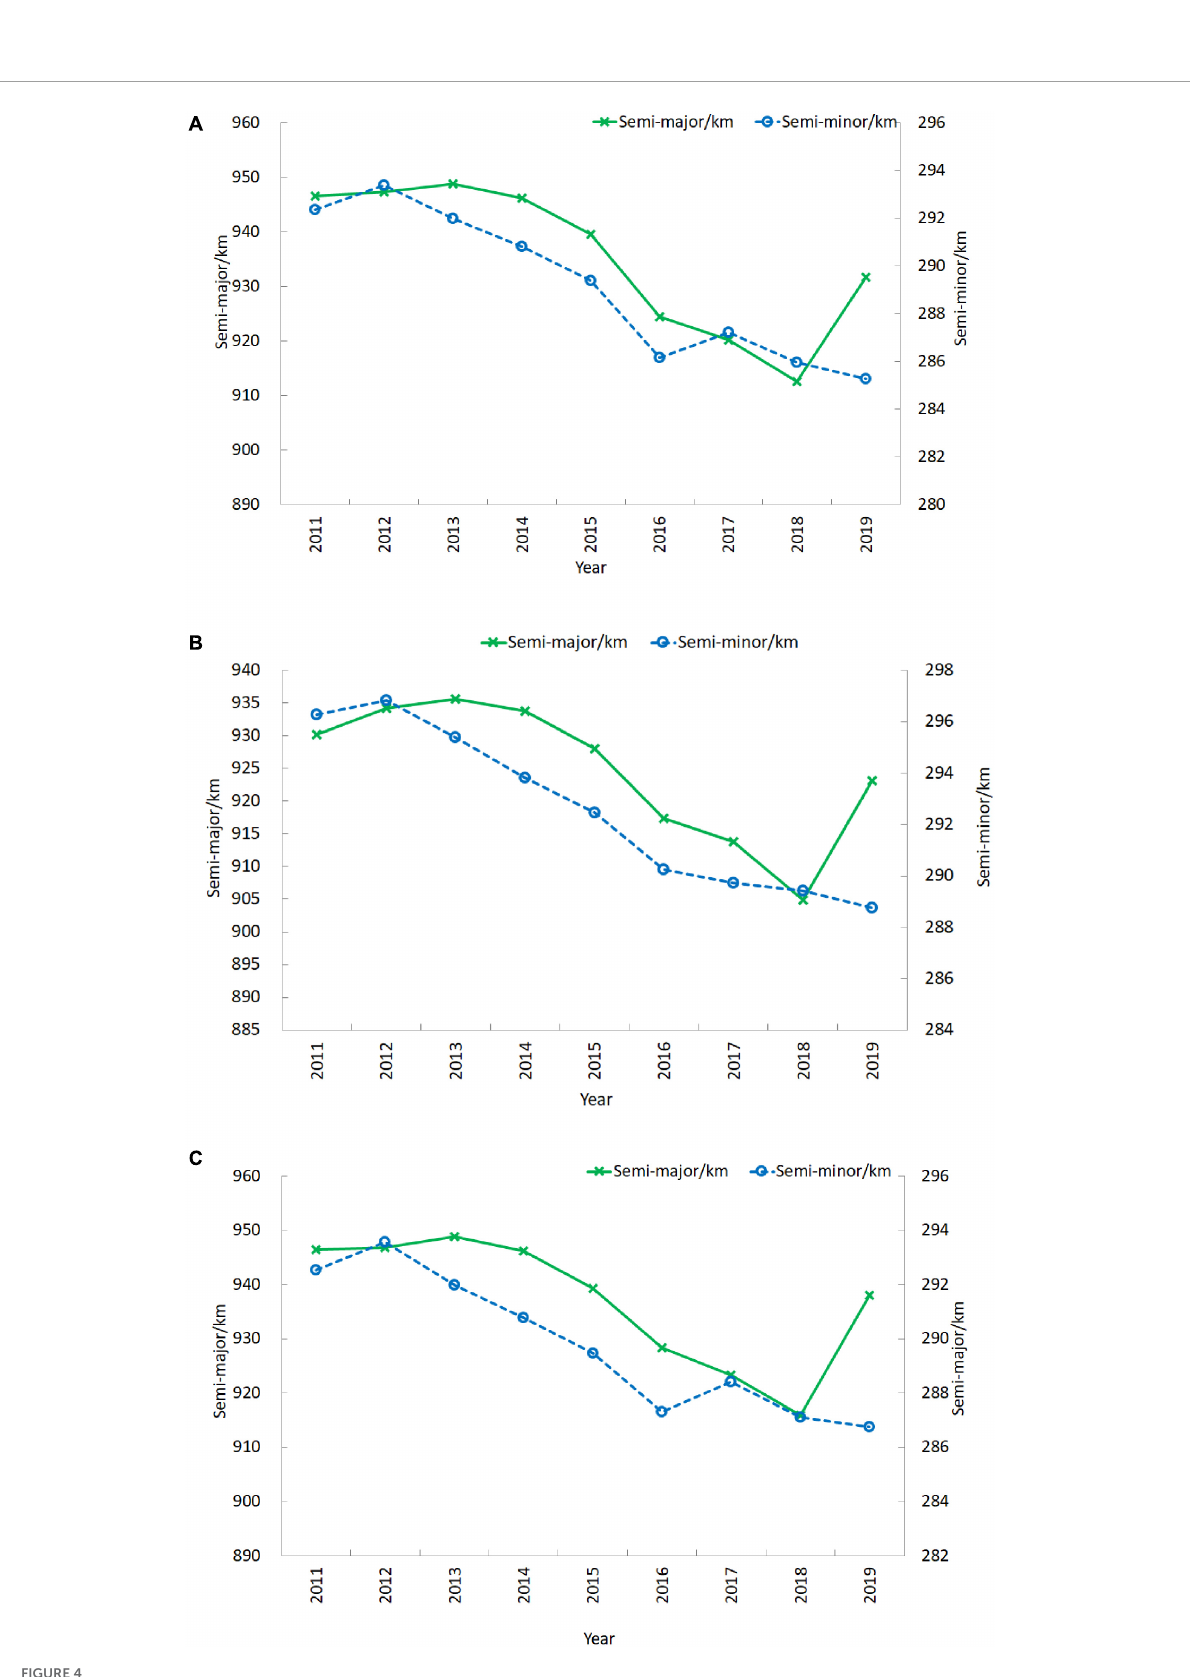
Frontiers in Ecology and Evolution